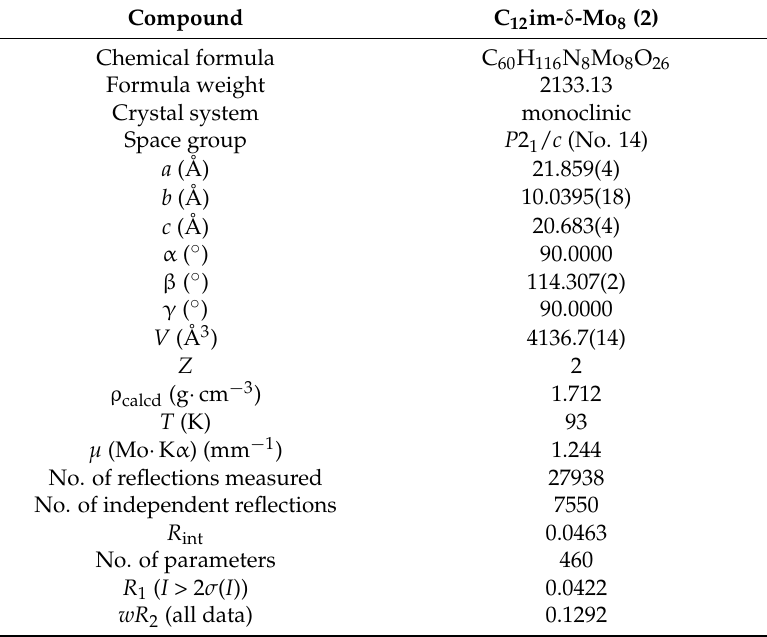
Table 1. Crystallographic